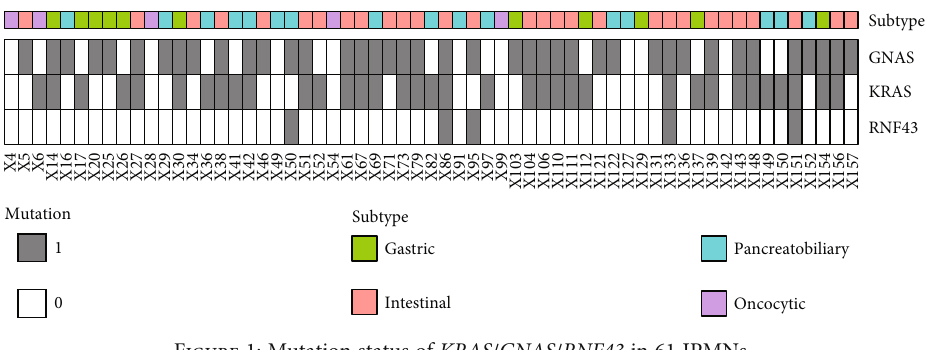
Figure 1: Mutation status of KRAS/GNAS/RNF43 in 61